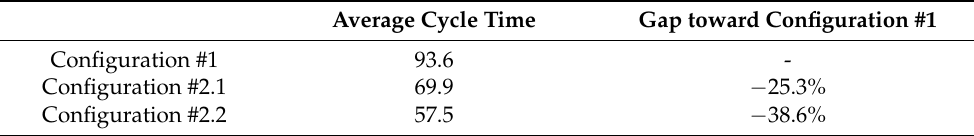
Table 2. Cycle time [s/pc] results for the three analyzed configurations.